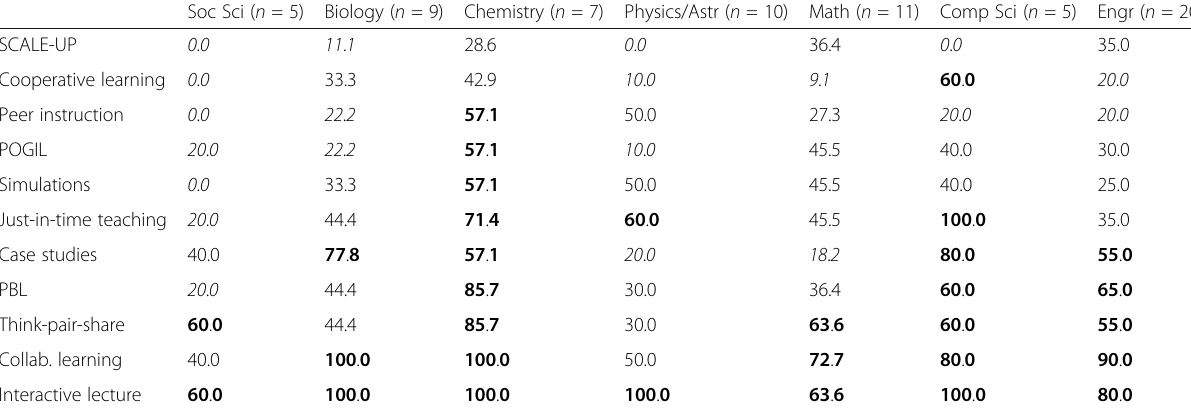
Table 12 Percentage of faculty who implement EBIPs in each